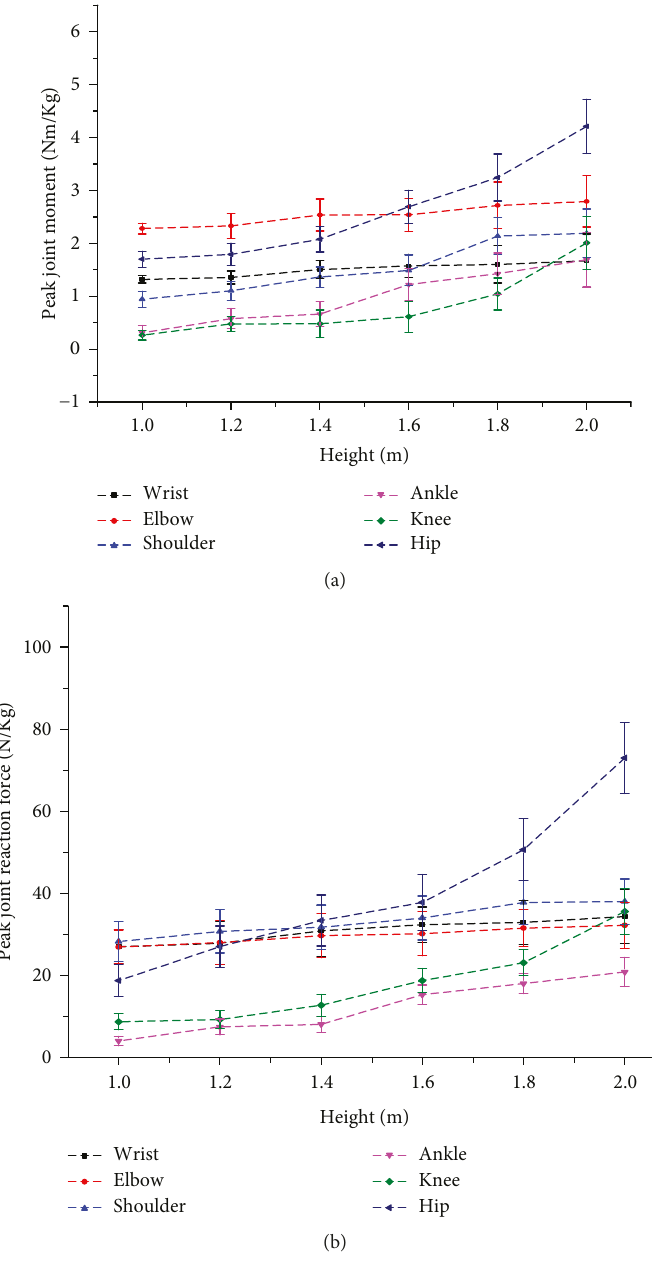
Figure 5: Mean and SD of the peak (a) joint moment and (b) joint reaction force versus jumping height for each joint during